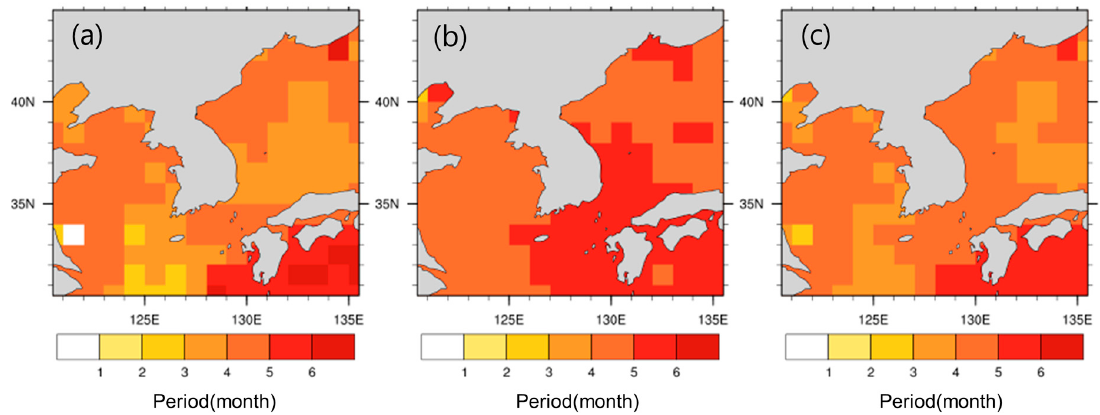
Figure 5. Horizontal distribution of the time lags for ( a ) the highest peak, ( b ) the lowest peak, and ( c ) the annual mean of the two peaks.